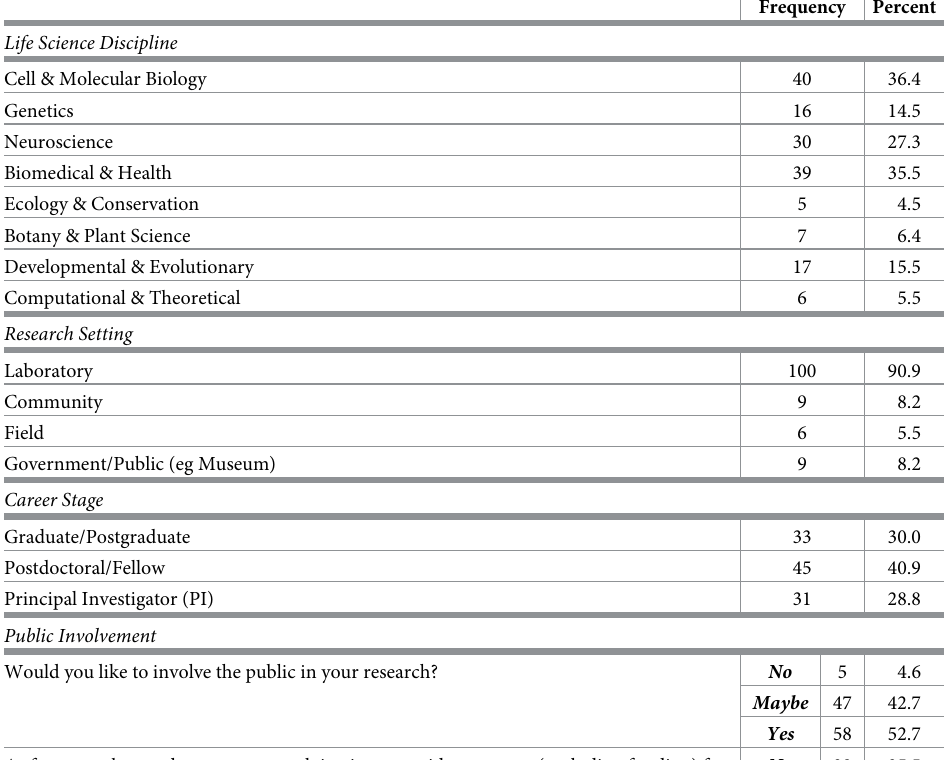
Table 1. Response